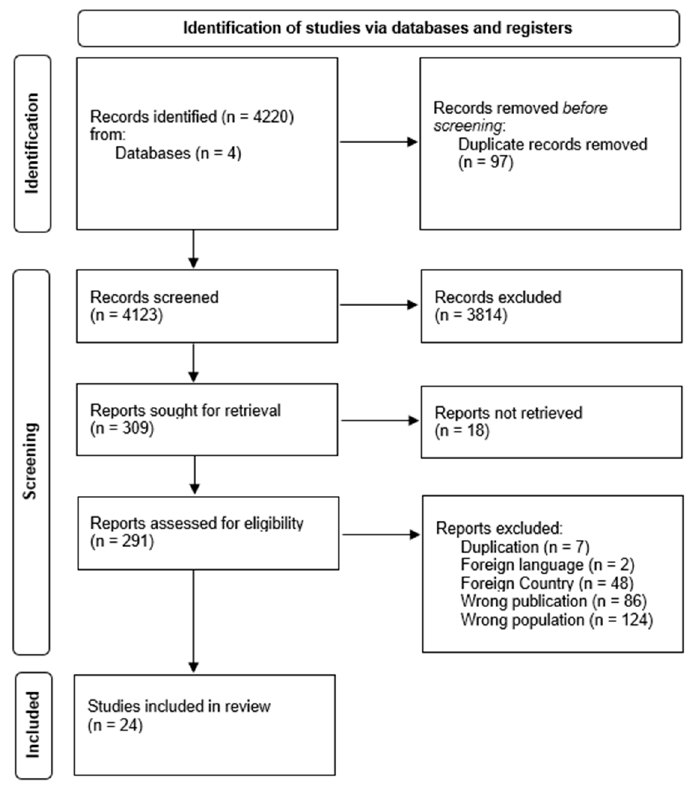
Figure 1. PRISMA Flow